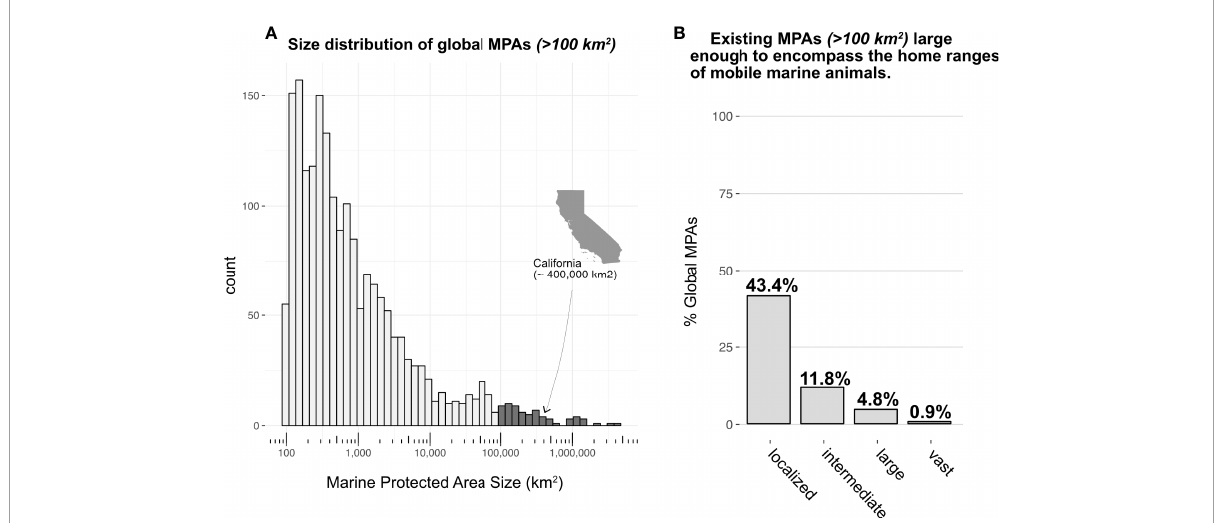
FIGURE 3 Size distributions of existing marine protected areas relative to home range sizes of mobile marine species. Less than 1% of all existing MPAs of all sizes (including those < 100 km 2 – not shown in histogram) can be classified as large MPAs (greater than 100,000 km 2 , dark grey shading, (A) ; California is included as a point of reference for size for large MPAs. Excluding MPAs that are less than 100 km 2 , just over 43% of remaining MPAs were large enough to encompass the home ranges of ‘localized’ species, but MPA coverage dropped off rapidly for species with ‘intermediate’, ‘large’, and ‘vast’ home ranges (B)